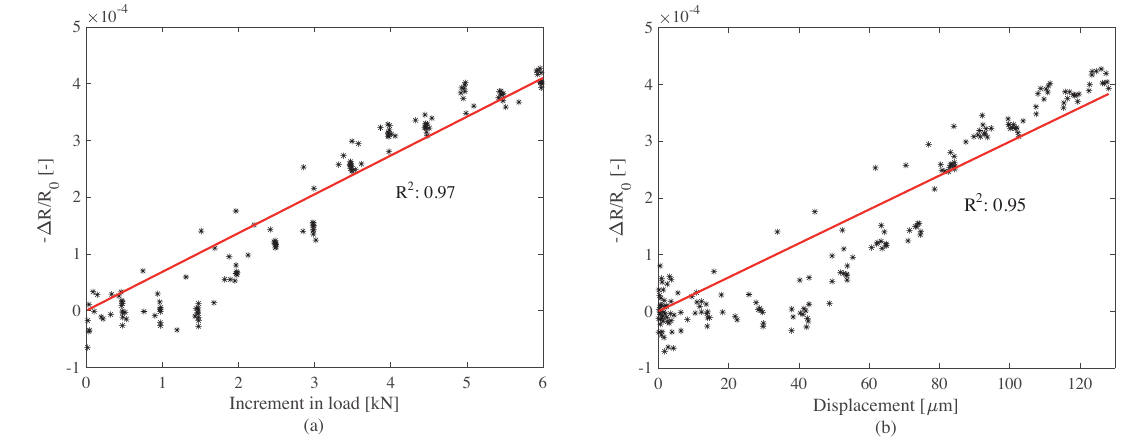
Figure 14. Linearity of the electrical signal with respect to ( a ) change in load and ( b ) change in displacement of the top of the